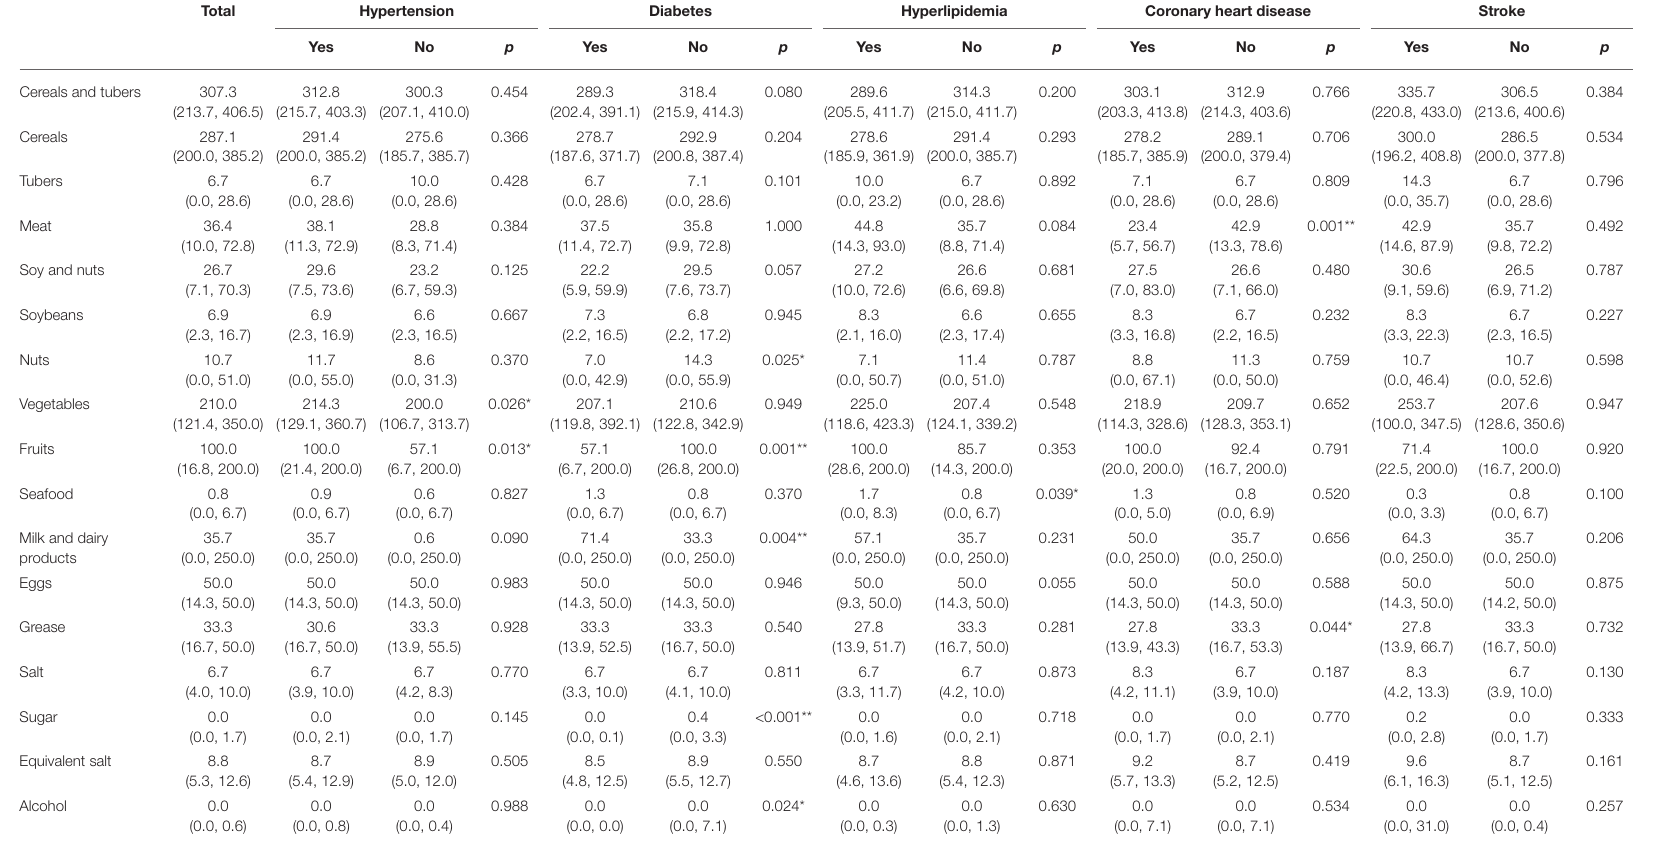
TABLE 2 | Dietary intake of the study population across chronic diseases categories. Total Hypertension Diabetes Hyperlipidemia Coronary heart disease